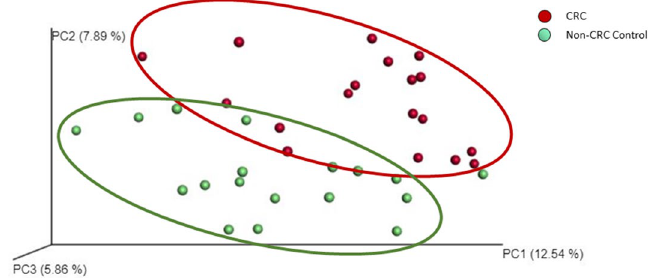
Figure 1. β-diversity of gut microbiome in CRC patients compared to non-CRC controls. Principal coordinates analysis (PCoA) plot of gut microbiome β-diversity in the subjects of this study based on unweighted UniFrac analysis.